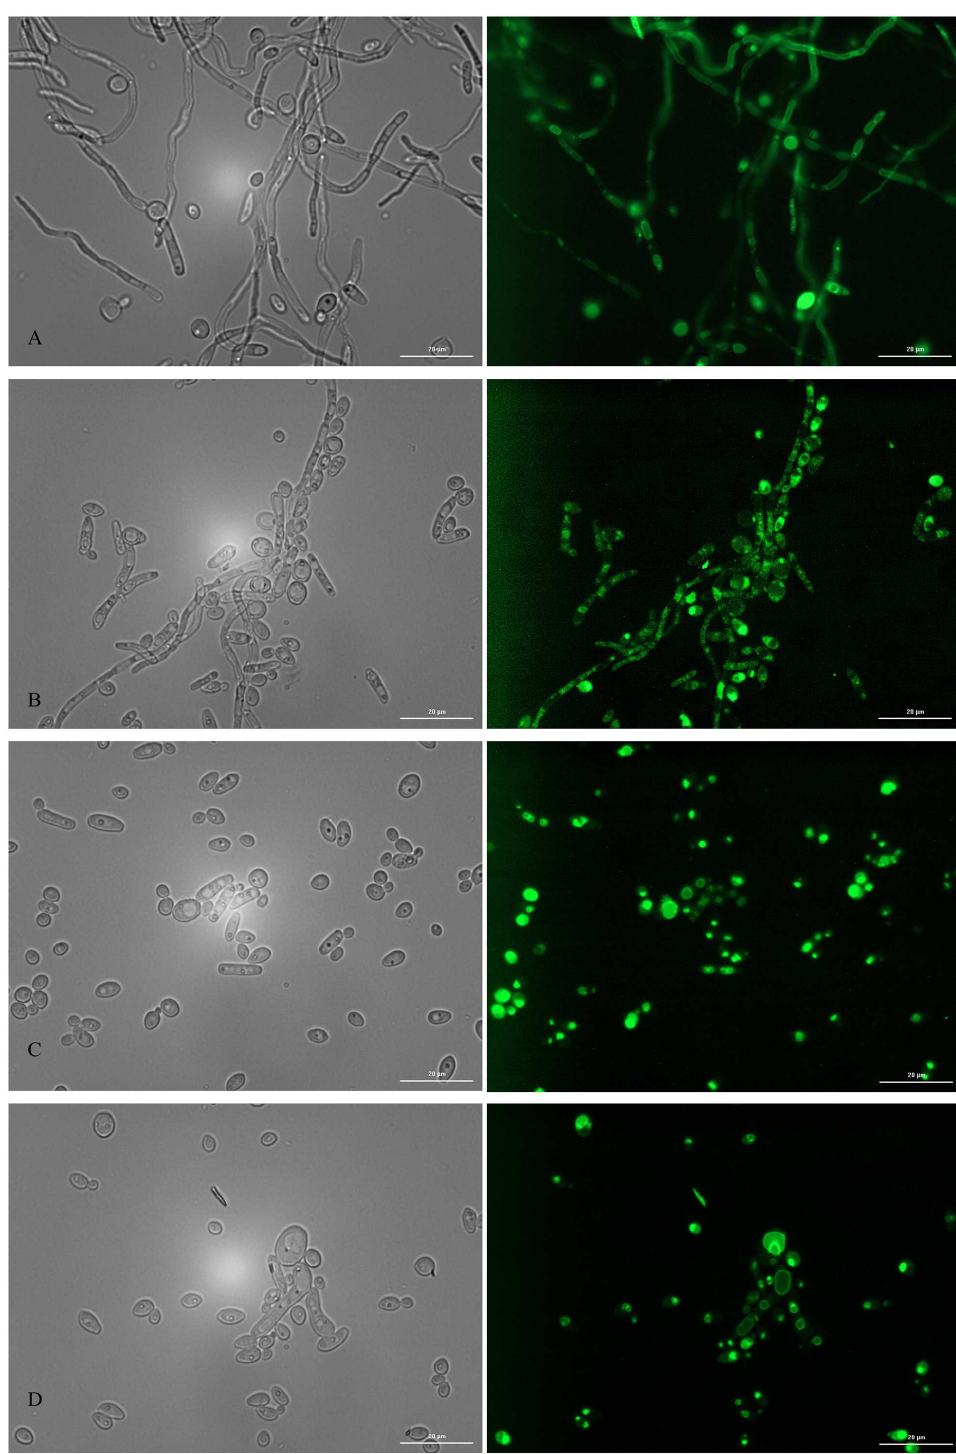
Fig 4. Hyphal growth assayin presenceof the 3 NSAIDs in the VDA collection. Hyphalgrowth was imagedafter 24h of growth at 37˚C in low glucoseconditionsusing a strain expressing GFP-YPT72. Cells were challenged with 0.5% DMSO (A), 50 μ M diflunisal(B), 50 μ M tolfenamicacid (C), and 50 μ M mefenamicacid (D). Images were acquiredusing a BioTek Synergy imagingreader at a 60X magnification for bright field imaging(left panels) and fluorescence (eGFP excitationfilter of 485/20; right panels). The error bars represent 20 microns.